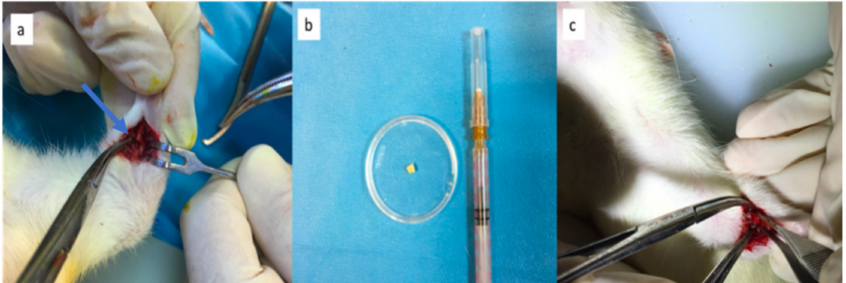
Figure 1. Surgical procedure. ( a ) Bone defect. ( b ) Decellularized omentum scaffold with mesenchy- mal stem cells. ( c ) Bone defect treated with scaffold. * Blue arrow shows the defective area.